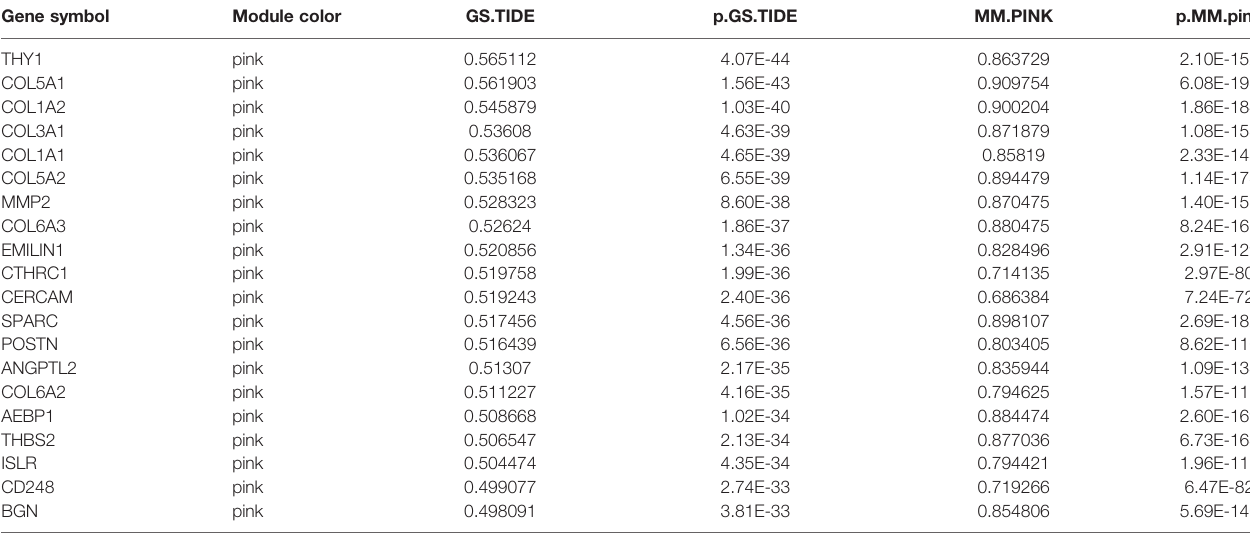
TABLE 2 | The top 20 hub genes in pink module.